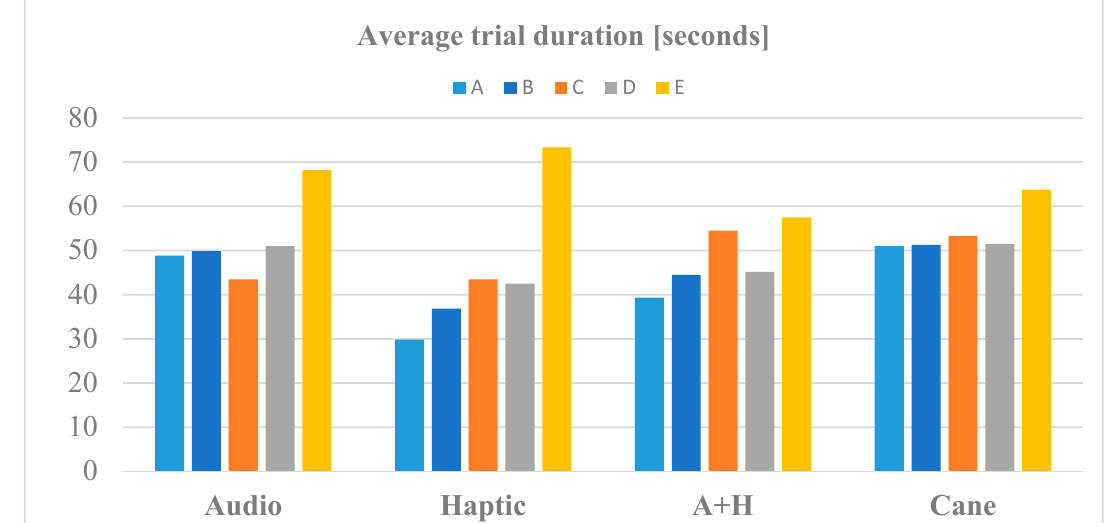
Figure 12. The average time to perform navigation tasks.